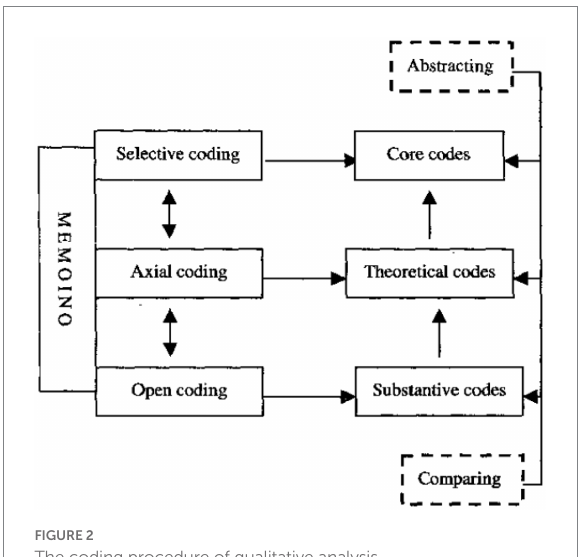
FIGURE 2 The coding procedure of qualitative